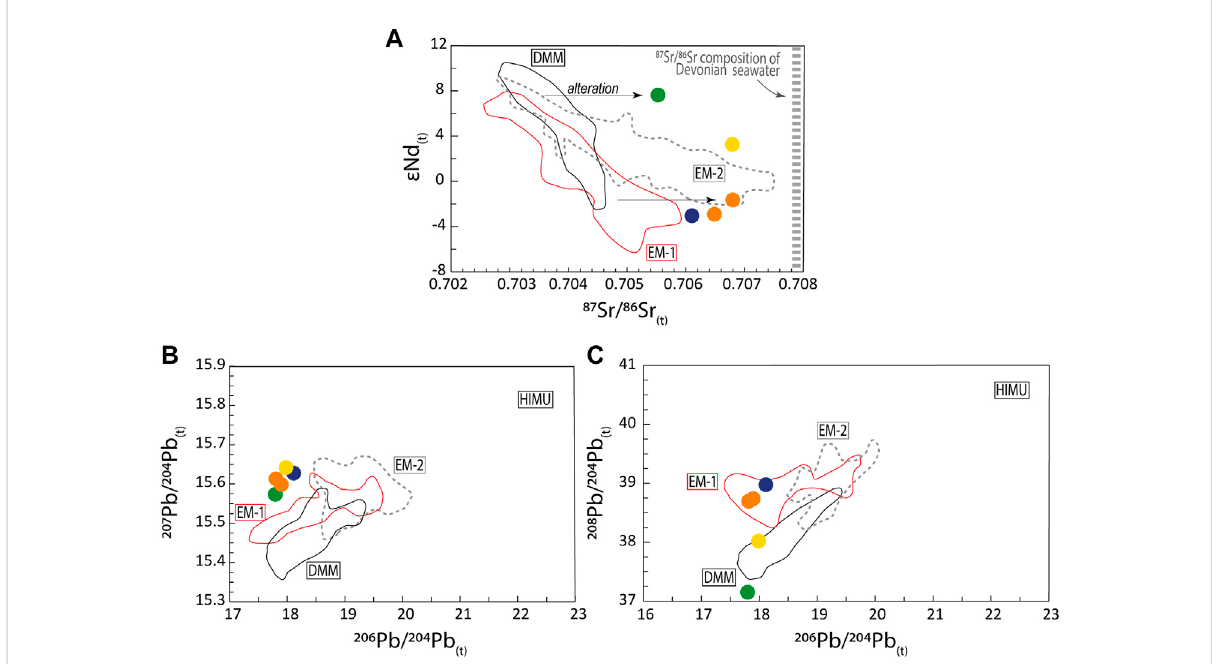
FIGURE 7 Time corrected ( t = 393 Ma) whole-rock isotope composition of the Zarao Metavolcanic Rocks. The compositional fi elds for DMM (Depleted MORBMantle),EM-1(EnrichedMantle1),andEM-2(EnrichedMantle2)correspondtocompiledanalysisfrommodernoceanicislandbasaltserupted at the “ type localities ” for each mantle “ reservoir ” (modi fi ed from the work of Hofmann, 2014). The 87 Sr/ 86 Sr composition of Devonian seawater is from the work of McArthur et al.